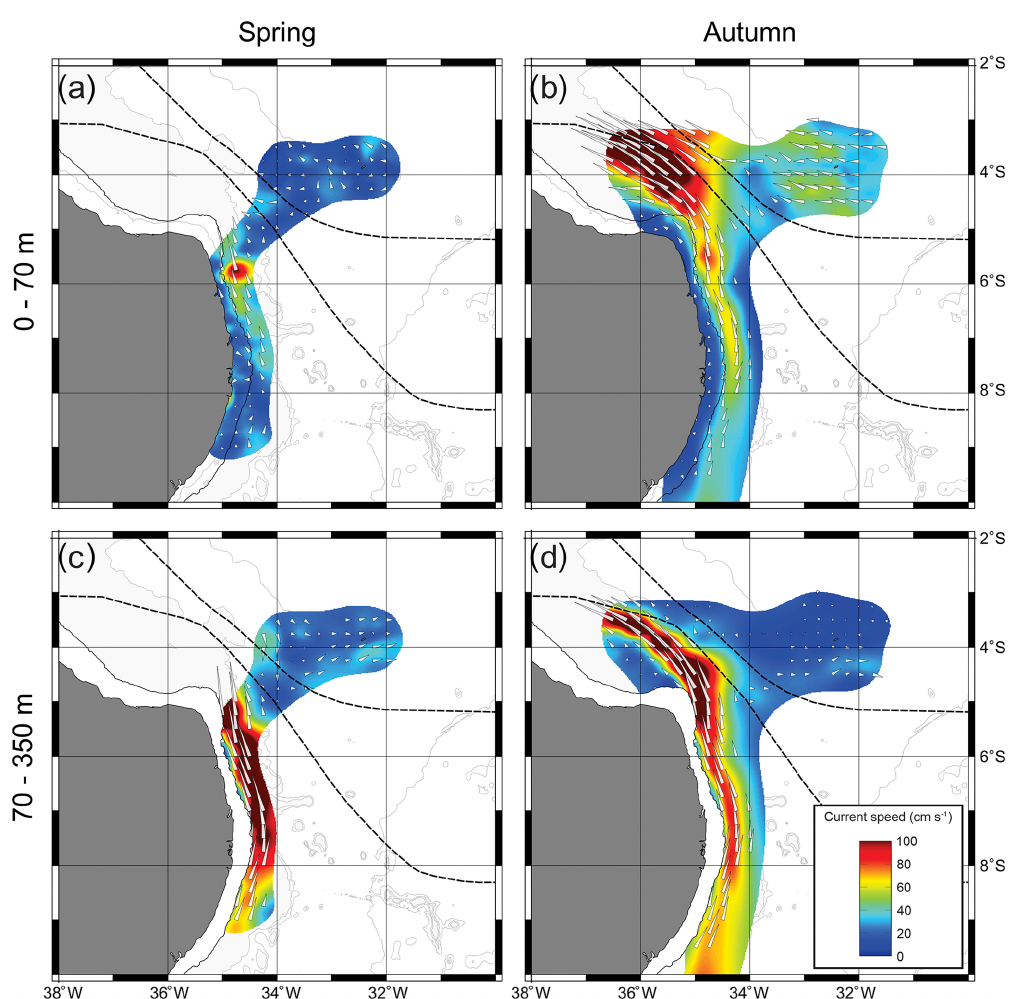
Figure 2. Surface (0–70m; a, b ) and deeper (70–350m; c, d ) current vectors and velocity of ADCP data during spring 2015 (a, c) and autumn 2017 (b, d) . Dashed lines indicate boundary between the WBCS, transition zone and